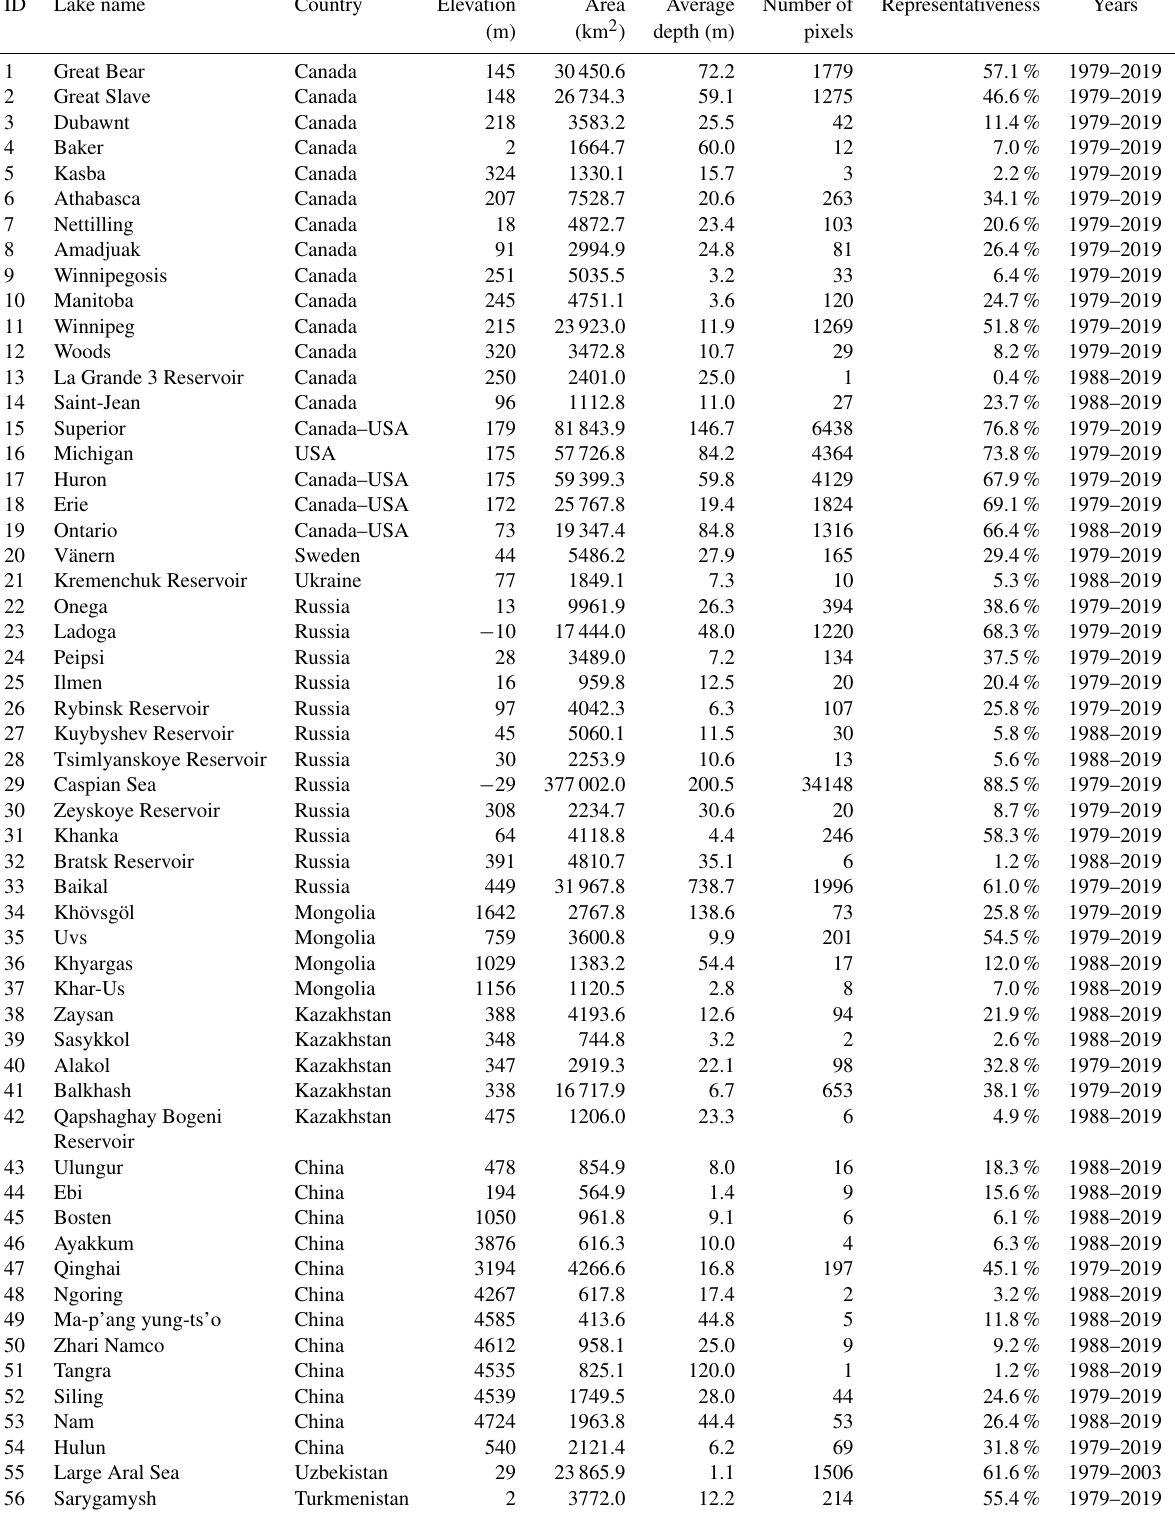
Table 1. The location and physical characteristics of the 56 study lakes as well as the number of pixels used for the lake ice phenology